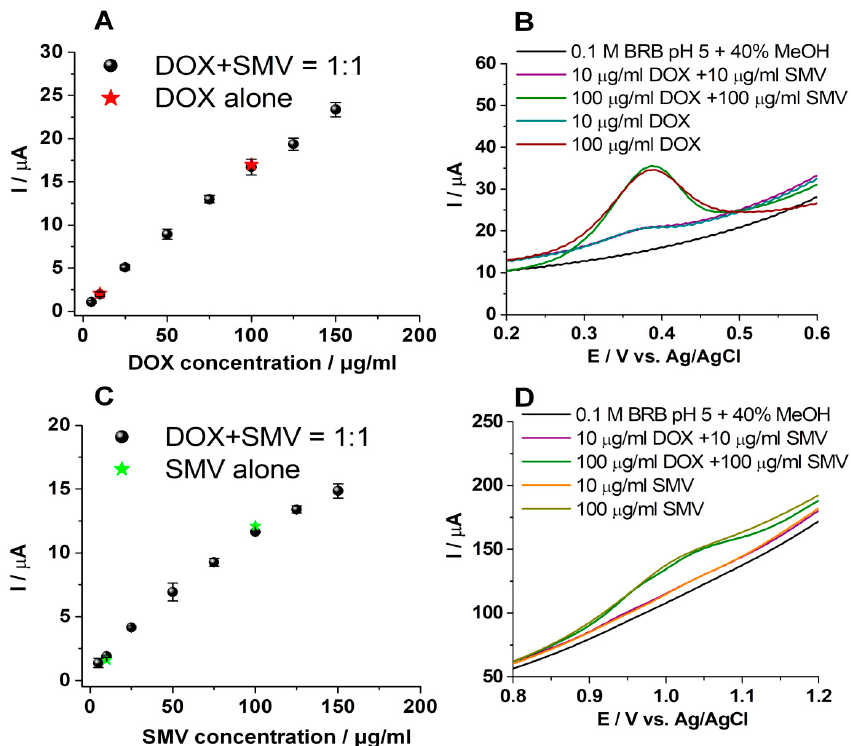
Figure 8. Calibration curves for DOX ( A ) and SMV ( C ) obtained by linear sweep voltammetry (LSV) in the presence of each other (equal concentrations of both analytes were tested). LSVs of different concentrations of DOX ( B ) and SMV ( D ) alone and in the presence of each other (see the legend of each figure for the correspondence between colors used and concentration). Scan rate: 100 mV/sl; potential range: (0, +1.5 V). Error bars were calculated based on the standard deviation obtained for 3 tests on 3 different